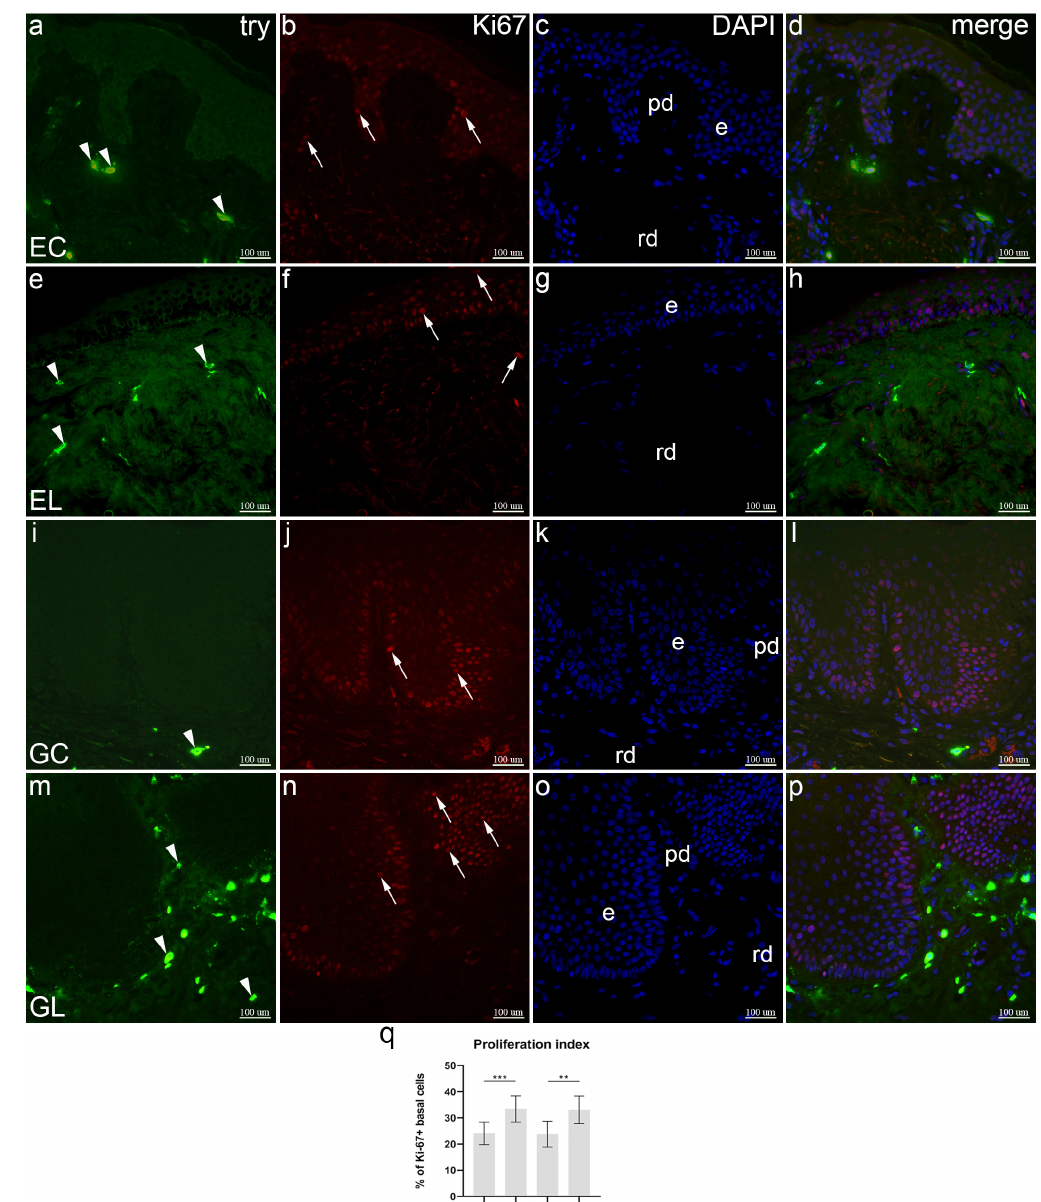
mast cells are displayed by tryptase staining ( n ); co-expression of VR1 and tryptase is seen in mast cells (arrows, ( p )). Double immunofluorescence staining to VR1, tryptase and DAPI, × 400 magnification. Analysis of mast cell density ( q ); statistical significance was determined by the Kruskal–Wallis test. N/mm denotes the number of mast cells per mm of dermal-epidermal junction. Graphs display mean values with standard deviations shown by error bars. The significance of differences is marked by asterisks: ** p < 0.01, *** p < 0.001.